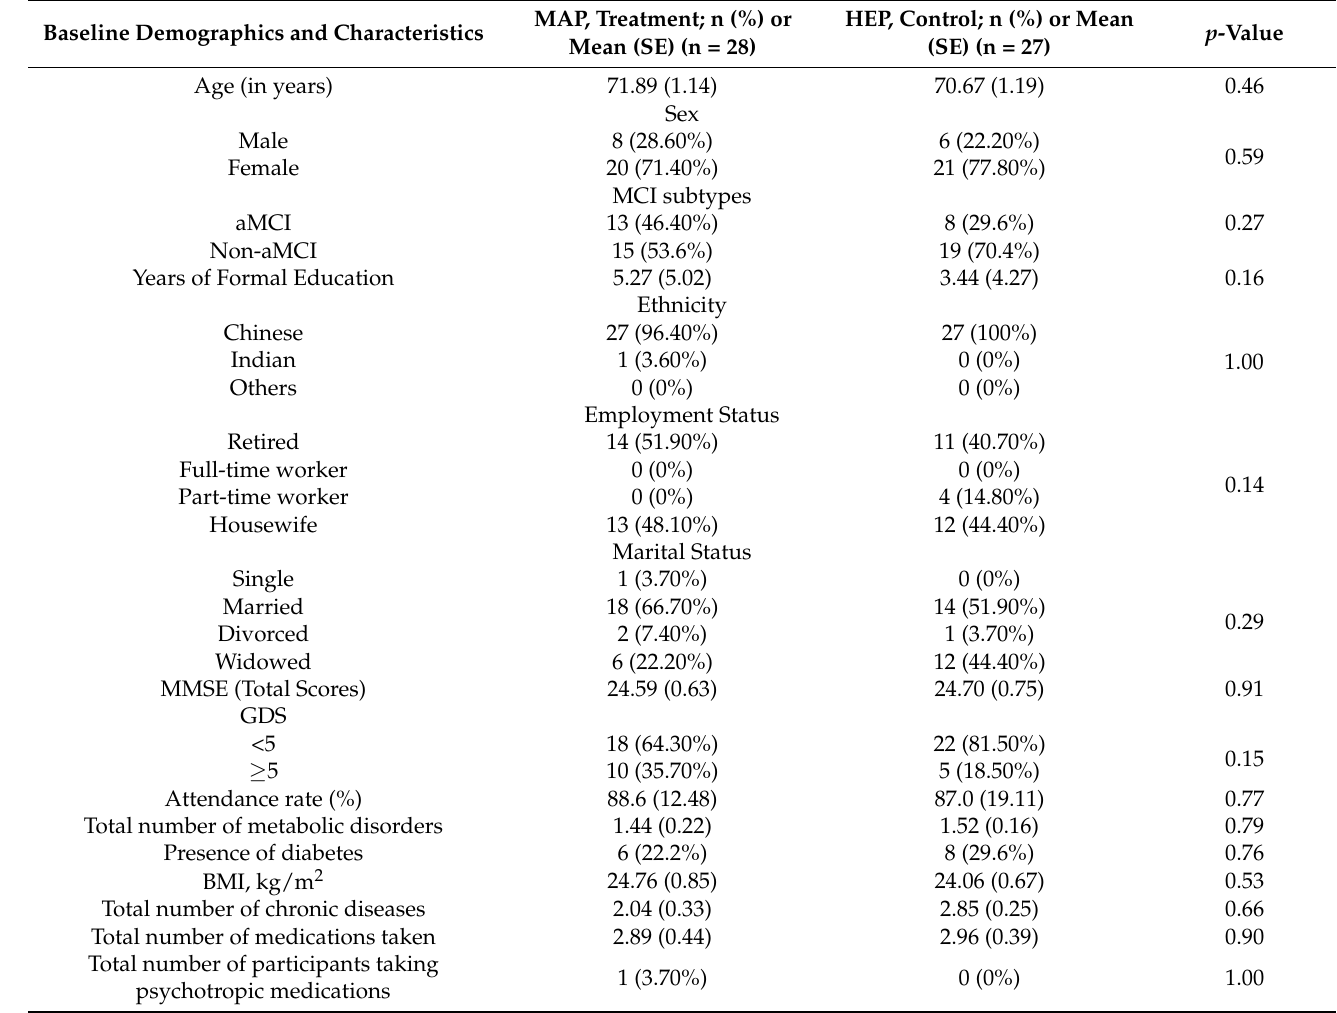
Table 2. Comparisons of the baseline demographic and characteristics between participants in the Mindful Awareness Practice (MAP) and Health Education Program (HEP) Arms (N =